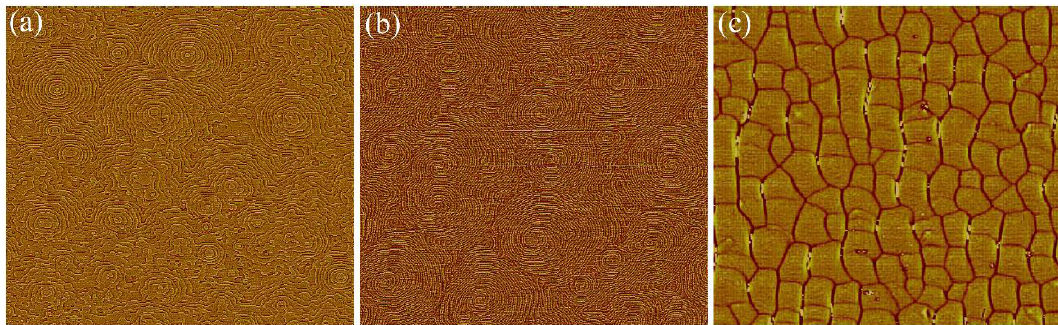
Figure 4. AFM differential images (20 μm × 20 μm) of GaSb surfaces grown in 3D spiral mode for #005 homoepitaxial GaSb ( a ), #011 IMF-GaSb ( b ), and #016 IMF-GaSb ( c ) samples.